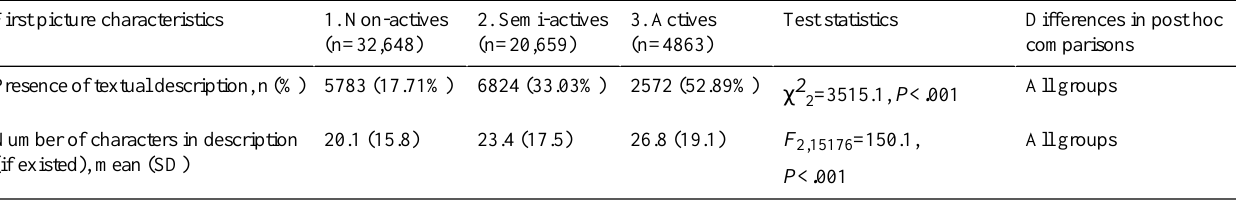
Table 6. Comparison of user engagement in the first self-monitoring entry between different adherence groups as measured by the presence and length of textual description for the